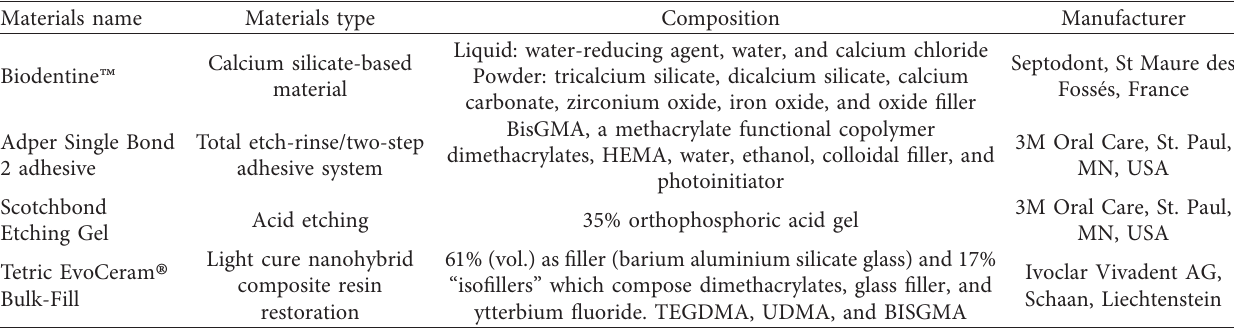
Table 1: Chemical composition and manufacturer information for tested materials.